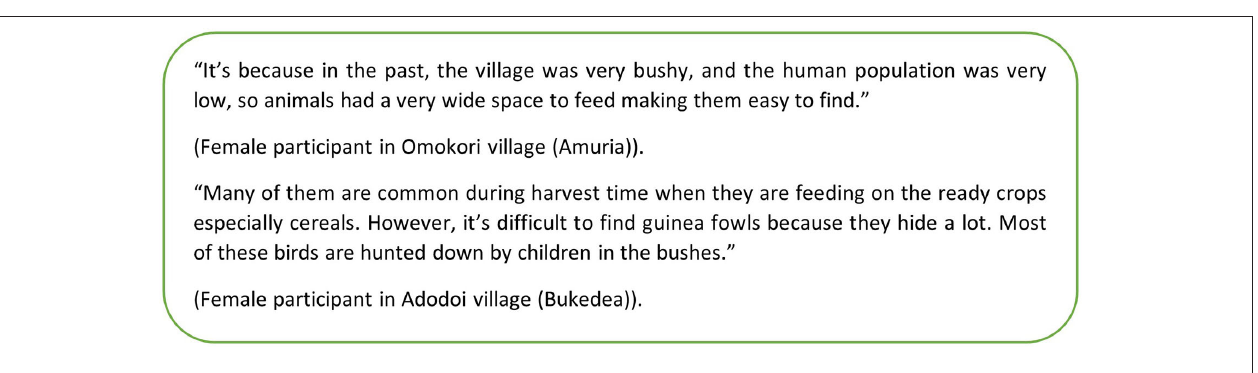
aggregated form can be found in Supplementary Table 8